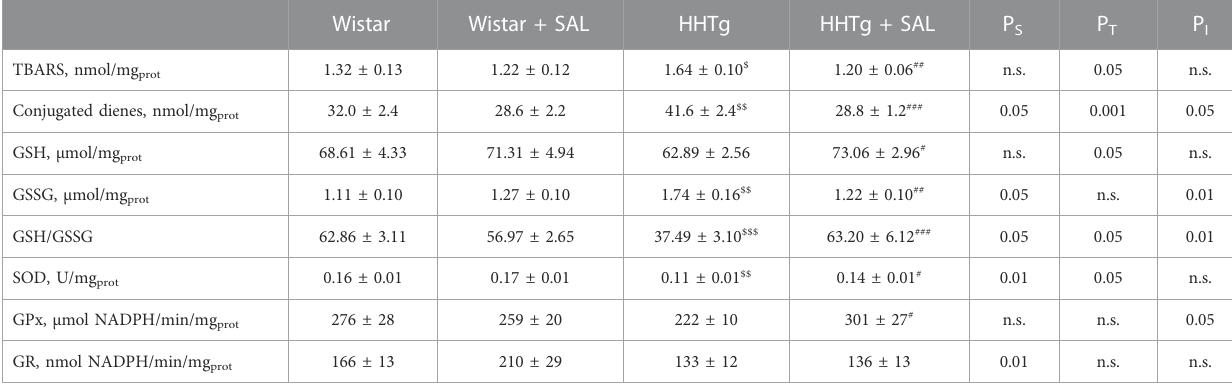
TABLE 2 Effect of salsalate treatment on hepatic oxidative stress parameters in Wistar control and prediabetic HHTg rats. Wistar Wistar +